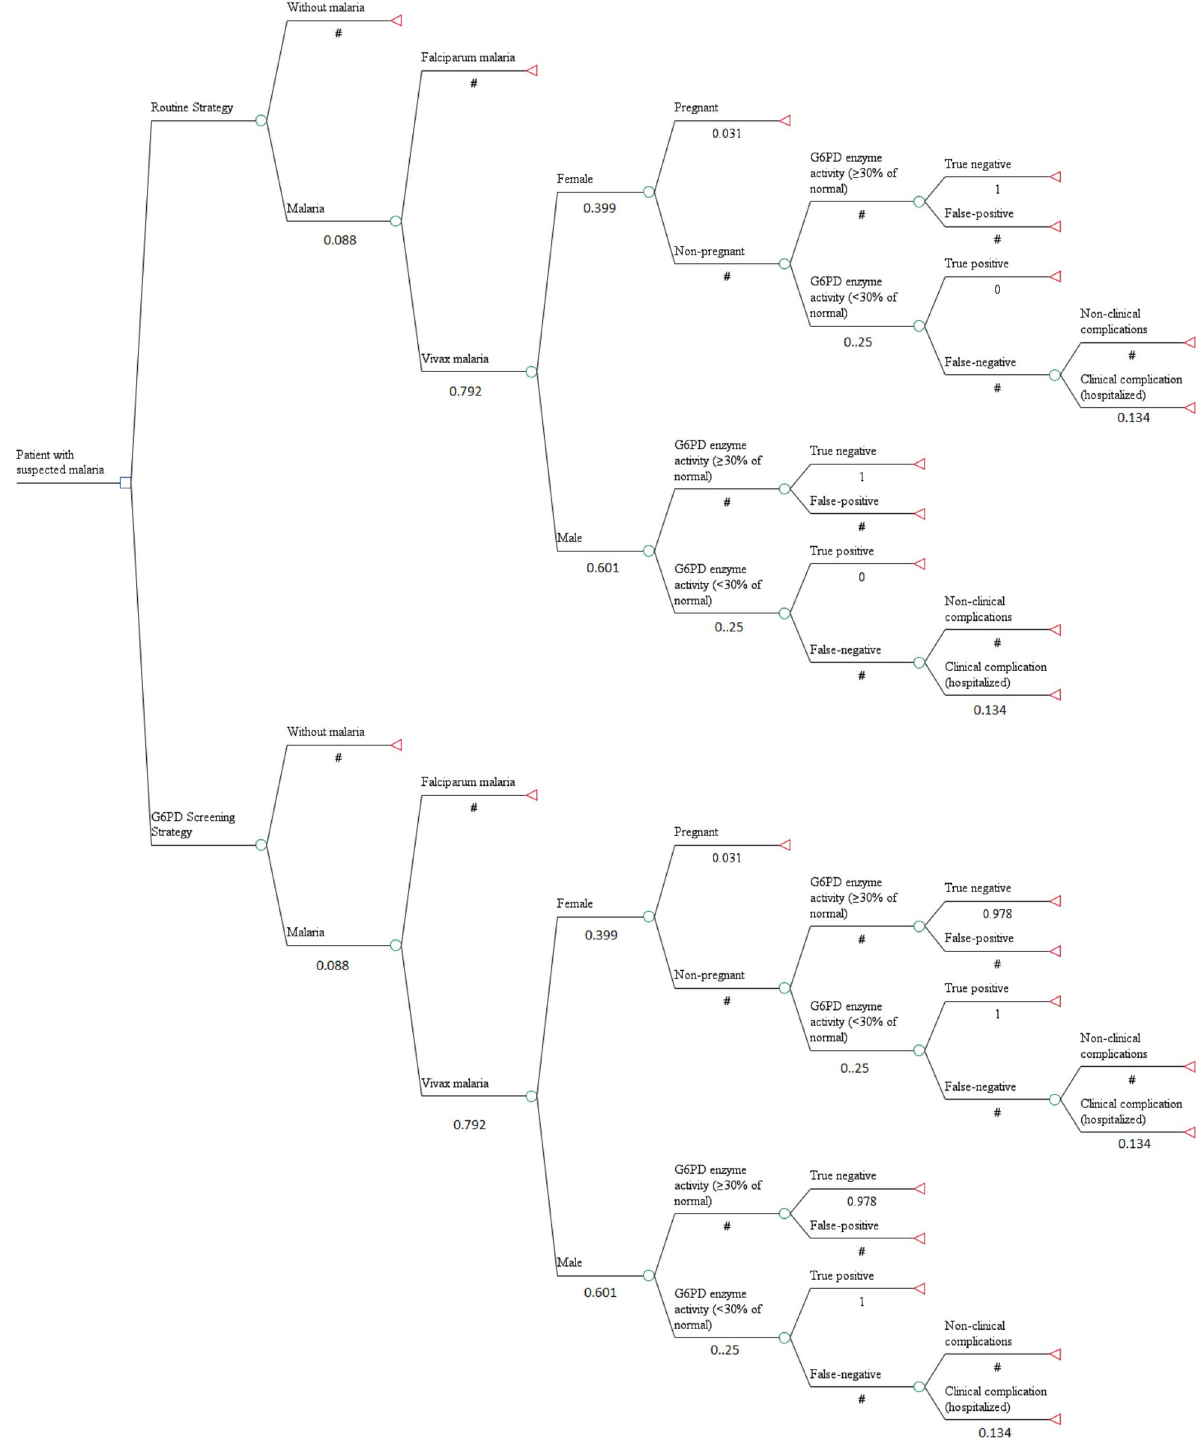
Fig 1. Analytical decision tree model used for cost-effectiveness analysis.